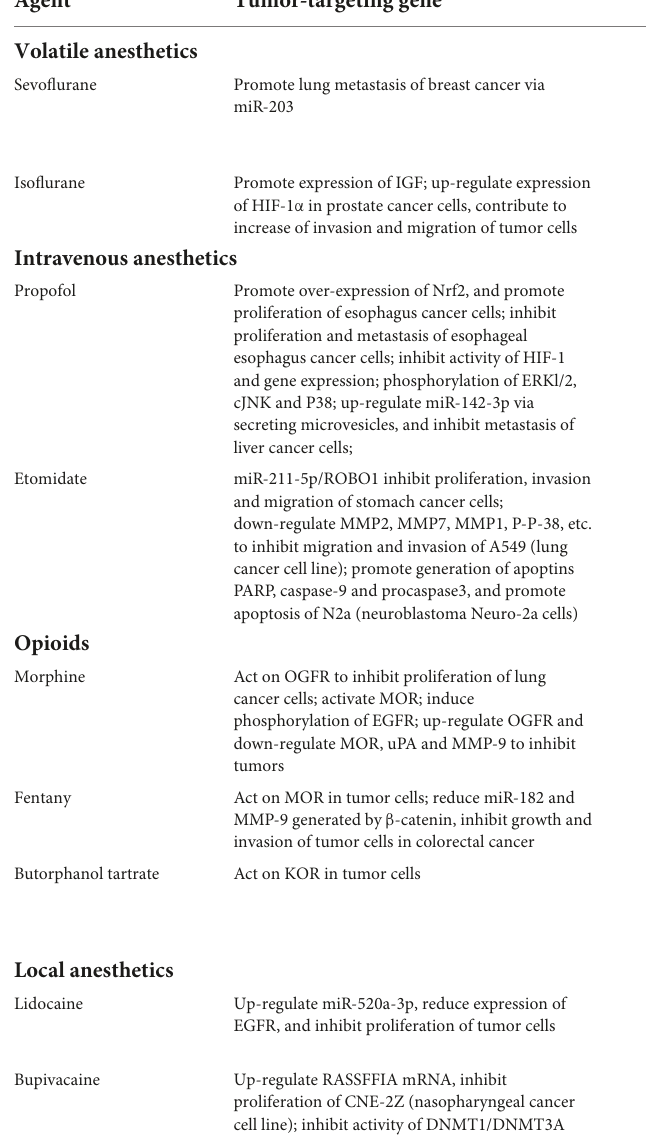
TABLE 2 Influence of tumor-targeting genes and signal transduction pathways in tumor cells. Agent Tumor-targeting gene